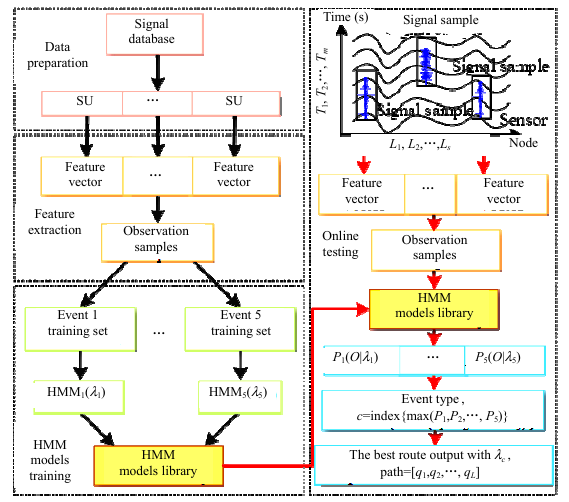
Fig. 31 Processing flow of the HMMs-based